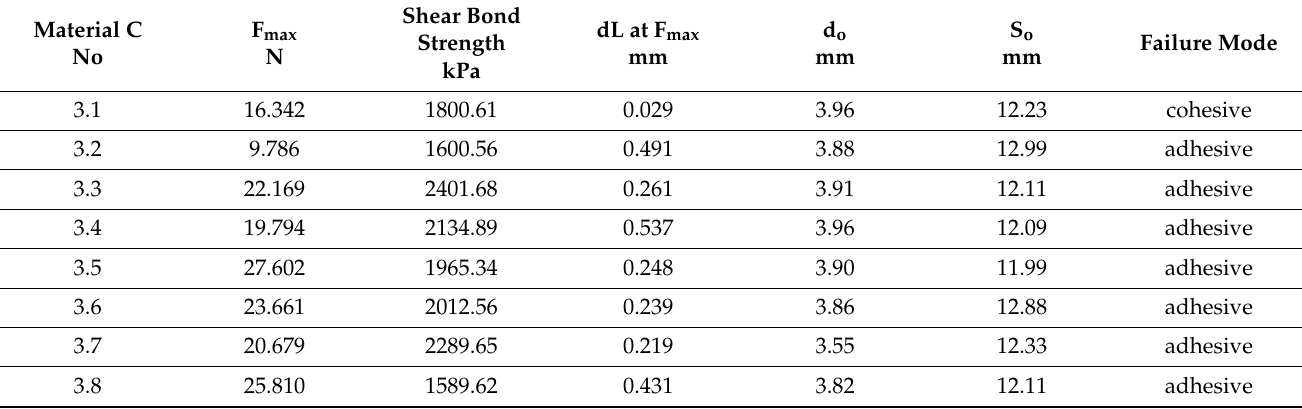
Table 4. The distribution of shear bond strength and failure modes of Spectrum™ (DENTSPLY, SIRONA).